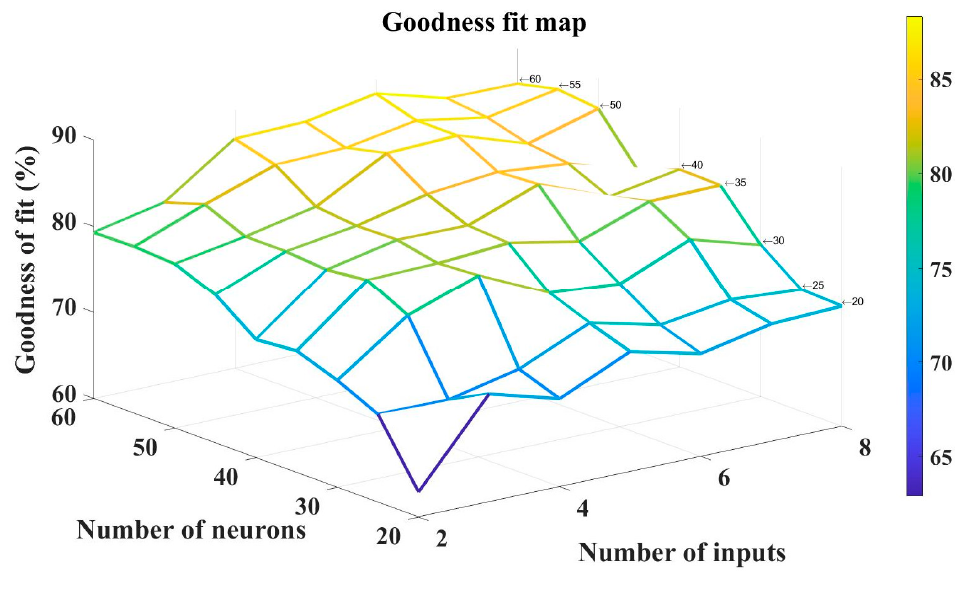
Figure 7. Goodness fit—3D map. Table 3. The learning success rate of LVQNN (%).